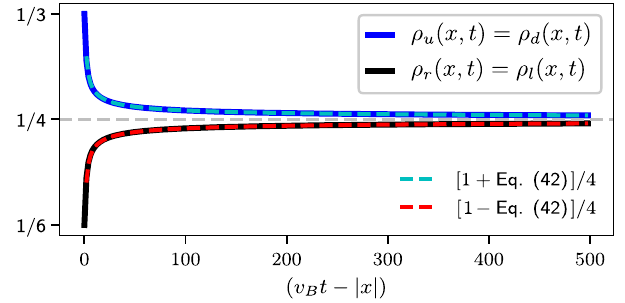
FIG. 4. Densities of local operators charged under “ spin ” and “ raising action ” behind the ballistic front of a spreading operator at q ¼ ∞ and late times Eq. (41). ρ u=d ð x; t Þ measures the local operator weight on site x on u=d operators that are charged under spin, while ρ r=l ð x; t Þ measures the local weight on r=l operators that have raising charge. Outside the ballistic operator front (at j x j > v B t ), the spreading operator locally is purely identities which contribute equally to ρ u=d ¼ 1 = 2 , but do not contribute to ρ 0 . The arrival of the front at a given site turns on a noisy r=l ¼ coupled diffusion process between the spin and raising charges which relaxes the initially imbalanced densities of these charges to the final “ equilibrium ” value where all local operators are equally likely. Note that ρ u ¼ ρ d and ρ r ¼ ρ l in this regime since any initial imbalances in raising or spin charges spread only diffusively and are not present near the ballistic front at late times. Dashed lines plot the “ coarse-grained ” densities in the scaling limit Eq.